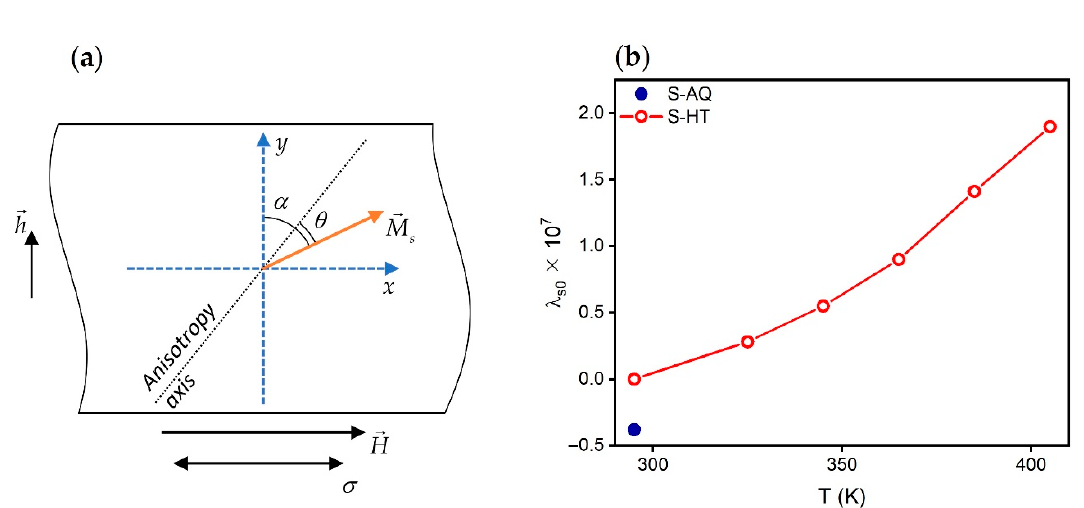
Figure 9. ( a ) Scheme for Equation (5). ( b ) Temperature dependence of the magnetostriction of the S-HT amorphous ribbon (empty symbols). The filled symbol shows the magnetostriction value of the S-AQ amorphous ribbon at room temperature.